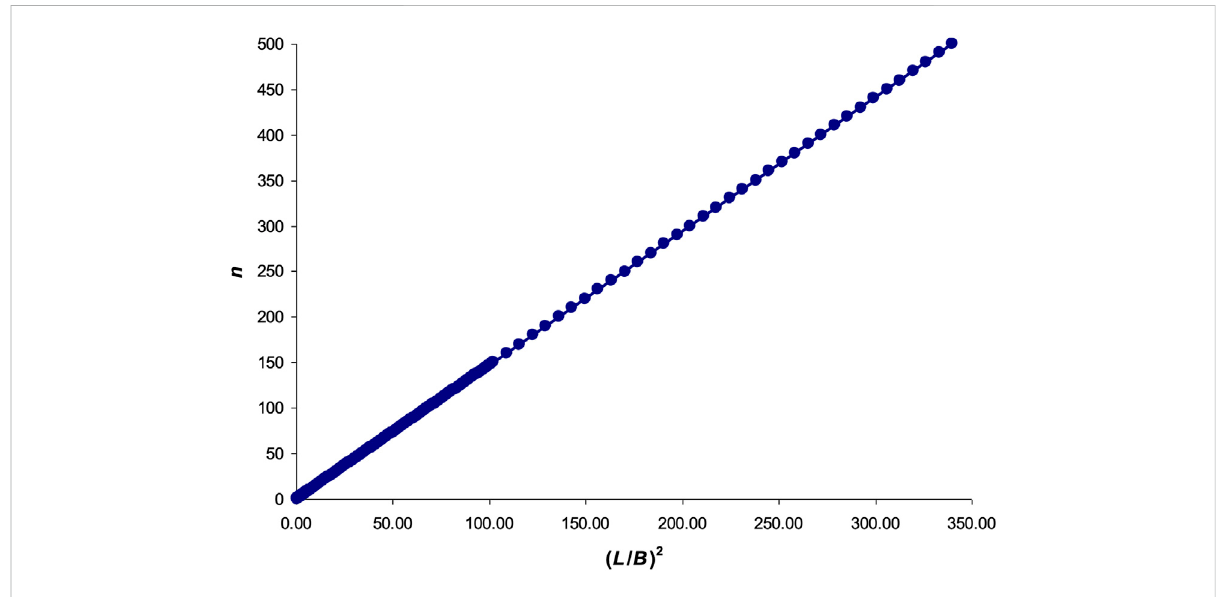
FIGURE 3 Graphical interpretation of Eq.